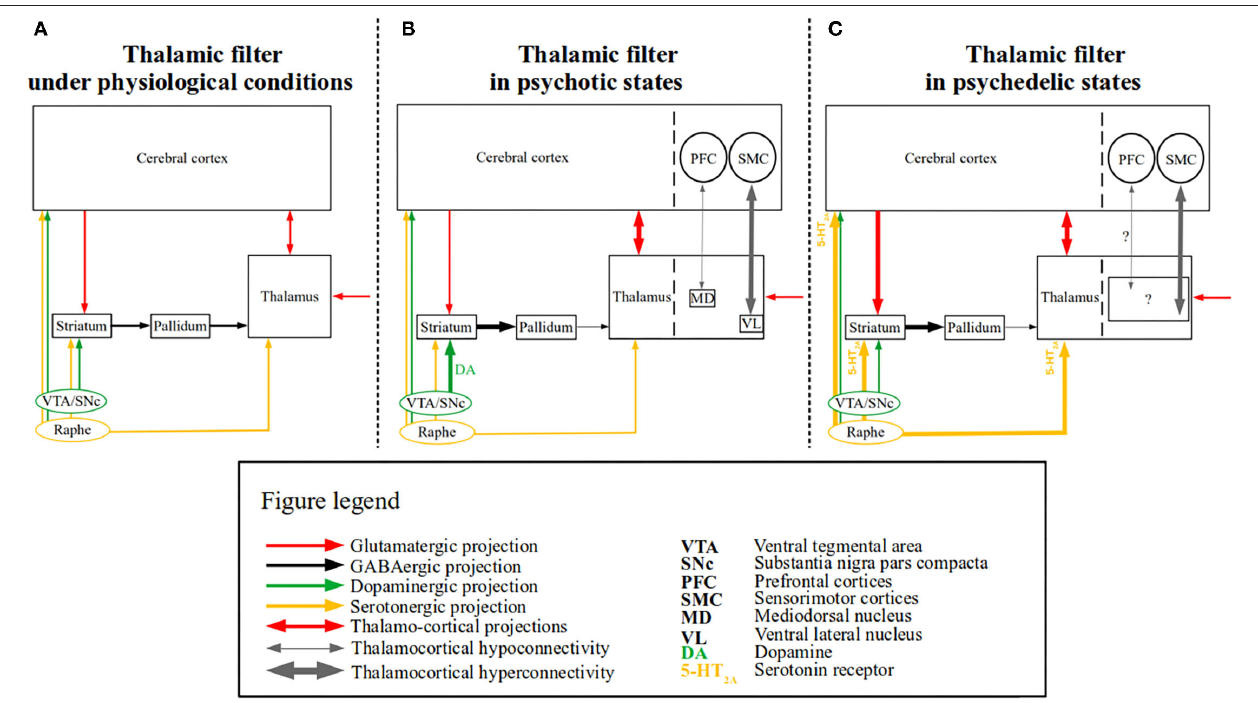
FIGURE 1 | The “thalamic filter” model in psychotic and psychedelic states. A simplified schematic of the “thalamic filter” model is depicted along with the associated thalamocortical dysconnectivity in psychotic and psychedelic states. (A) Depicts thalamic filtering under physiological conditions, in which thalamic activity is modulated by several sources (e.g., cortico-striatal), which are in turn modulated by distinct neurotransmitter systems. Glutamatergic (red arrows), GABAergic (black arrows), dopaminergic (green arrows), and serotonergic projections (yellow arrows) are shown. Cortico-striatal projections are depicted by a unidirectional red arrow from the cerebral cortex to the striatum, whereas the reciprocal projections between the thalamus and the cerebral cortex are depicted by a bidirectional red arrow. Finally, incoming (glutamatergic) sensory input to the thalamus is depicted by a red unidirectional arrow. (B) Depicts a proposed model of altered thalamic filtering in psychotic states, induced via aberrant dopamine function, based on the model provided by Carlsson et al. ( 19). The left side shows the impaired thalamic filter function, which is induced by excess dopamine (shown as DA) and increased dopaminergic signaling (depicted by the thick green arrow), which leads to an increased inhibition of the pallidum via the striatum (depicted by the thick black arrow) and reduced thalamic inhibition via the pallidum (depicted by the thin black arrow). The enhanced thalamic disinhibition (i.e., “opening” of the thalamic filter) results in sensory flooding (depicted by the thick bidirectional red arrow between the thalamus and the cerebral cortex), presumably bringing about (psychotic) symptoms [for similar models see ( 20, 21)]. On the right side, separated by the dashed line both in the cerebral cortex and thalamus, rsfMRI findings of thalamocortical dysconnectivity in psychotic disorders are summarized [e.g., (22, 23)]. Thalamocortical hyperconnectivity (depicted by the thick bidirectional gray arrow) between the ventrolateral thalamus (VL) and sensorimotor cortices (SMC) and hypoconnectivity (depicted by the thin bidirectional gray arrow) between mediodorsal thalamus (MD) and prefrontal cortices (PFC), are shown. (C) Depicts a proposed model of altered thalamic filtering in psychedelic states, slightly modified from (9, 18). The left side shows the impaired thalamic filter function induced by psychedelic stimulation of 5-HT 2A receptors, which leads to increased extracellular glutamate levels in the prefrontal cortex and inhibitory activity of interneurons in the basal ganglia, thereby increasing the excitatory effect of pyramidal neurons both on the basal ganglia (depicted by the thick unidirectional red arrow between the cerebral cortex and the striatum) and the thalamus (depicted by the thick bidirectional red arrow between the cerebral cortex and the thalamus) (24, 25). Recent evidence also indicates that psychedelics (i.e., LSD) modulate activity in the reticular thalamus leading to the disinhibition of other thalamic nuclei (i.e., mediodorsal nucleus—not shown) (26). In parallel, the increased striatal activity leads to a similar chain of events as seen in psychotic states (i.e., also resulting in enhanced thalamic disinhibition) (18). On the right side, separated by the dashed line both in the cerebral cortex and thalamus, rsfMRI findings of thalamocortical dysconnectivity in psychedelic states